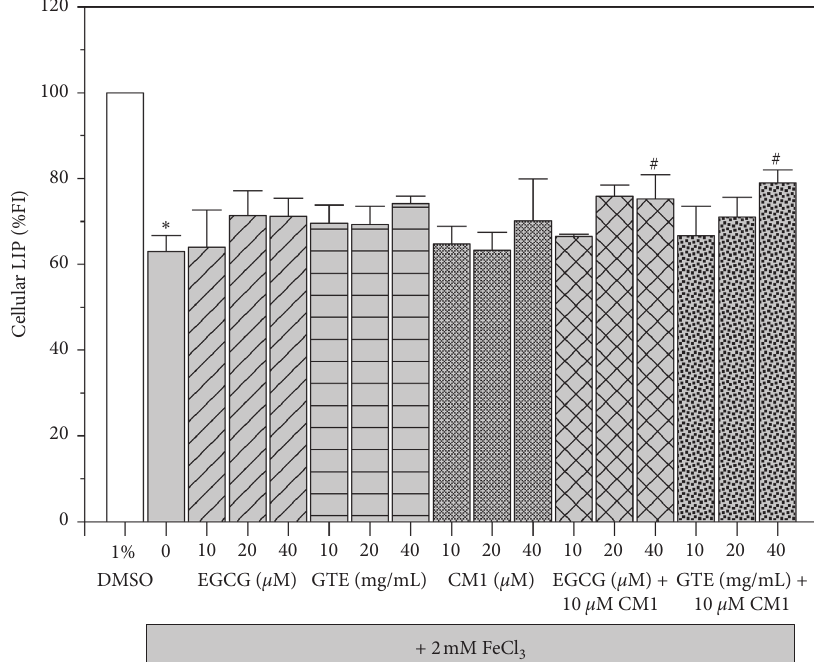
Figure 3: Levels of LIP in SH-SY5Y cells with iron loading condition. SH-SY5Y cells were being exposed with or without 2 mM FeCl After that, the cells were then treated with 1% DMSO, CM1 (10–40 μ M), EGCG (10–40 μ M), GTE (10, 20, and 40 mg/mL equivalent to 5.24, 10.48, and 20.96 μ M EGCG, respectively), and combinations for 24 h. Data obtained from three independent duplicate experiments are expressed as mean ± SEM values. ∗ P < 0 . 05 when compared to the untreated cells without iron loading; # P < 0 . 05 when compared to the iron-loaded cells treated with 1%